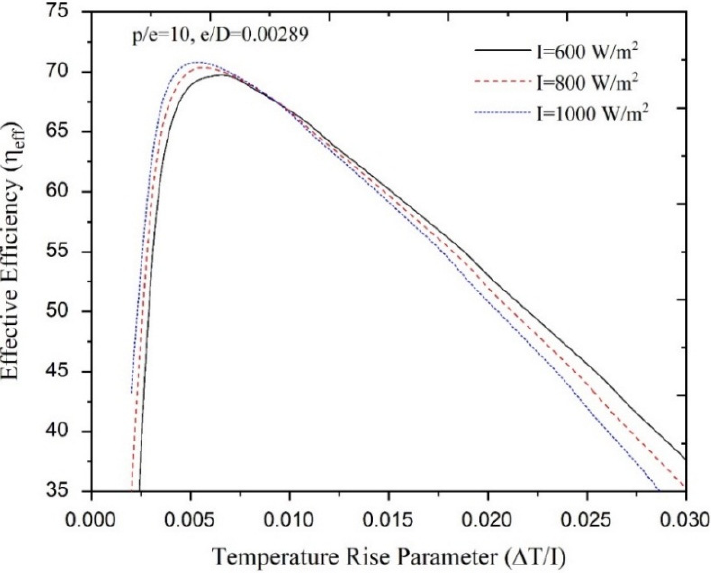
Figure 10. Effect of solar insolation on net effective efficiency.